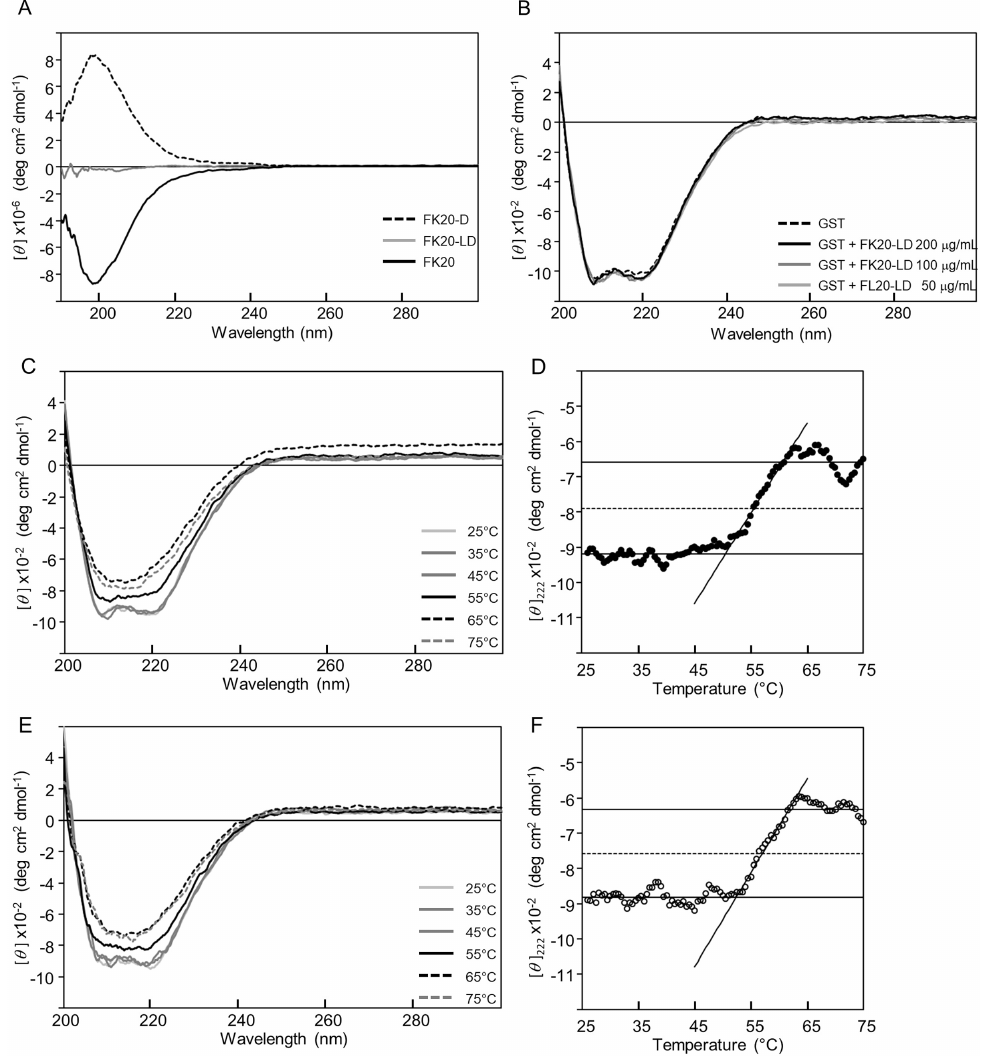
Figure 4 In fl uence of IDP-derived peptide FK20 and its all D-enantiomeric isomer FK20-D to the structure and thermal stability of GST. (A) CD spectra of 250 m g/ml of FK20 (solid line), FK20-D (dashed line) and equimolar mixture (125 m g/ml each) FK20-LD (grey line) at 25 (cid:1) C. (B) CD spectra of 100 m g/ml GST without (dashed line) or with (solid lines) 50, 100, and 200 m g/ml of FK20-LD at 25 (cid:1) C. (C) CD spectra of 100 m g/ml GST alone at various temperatures. (E) CD spectra of 100 m g/ml GST with 200 m g/ml of FK20-LD at various temperatures ranging 25 (cid:1) C to 75 (cid:1) C. (D, F) Melting curve of GST with (F) or without (D) FK20-LD monitored by the residual molar ellipticity [theta] at 222 respectively. The GST thermal denaturation temperature (T ) was 56.5 ± 1.2 (cid:1) C for GST m alone, and 58.2 ± 1.1 (cid:1) C in the presence of 0.2 mg/ml of FK20-LD. Similarly, Fig. 5A shows the CD spectra of LDH in the absence (dashed line) and presence (solid line) of FK20-LD. Figures 5B and 5D show initial and fi nal LDH CD spectra at increasing temperatures from 25 (cid:1) C to 75 (cid:1) C with and without FK20-LD. Figures 5C and 5E show LDH thermal denaturation plots taken from Figs. 5B and 5D s, respectively. The LDH